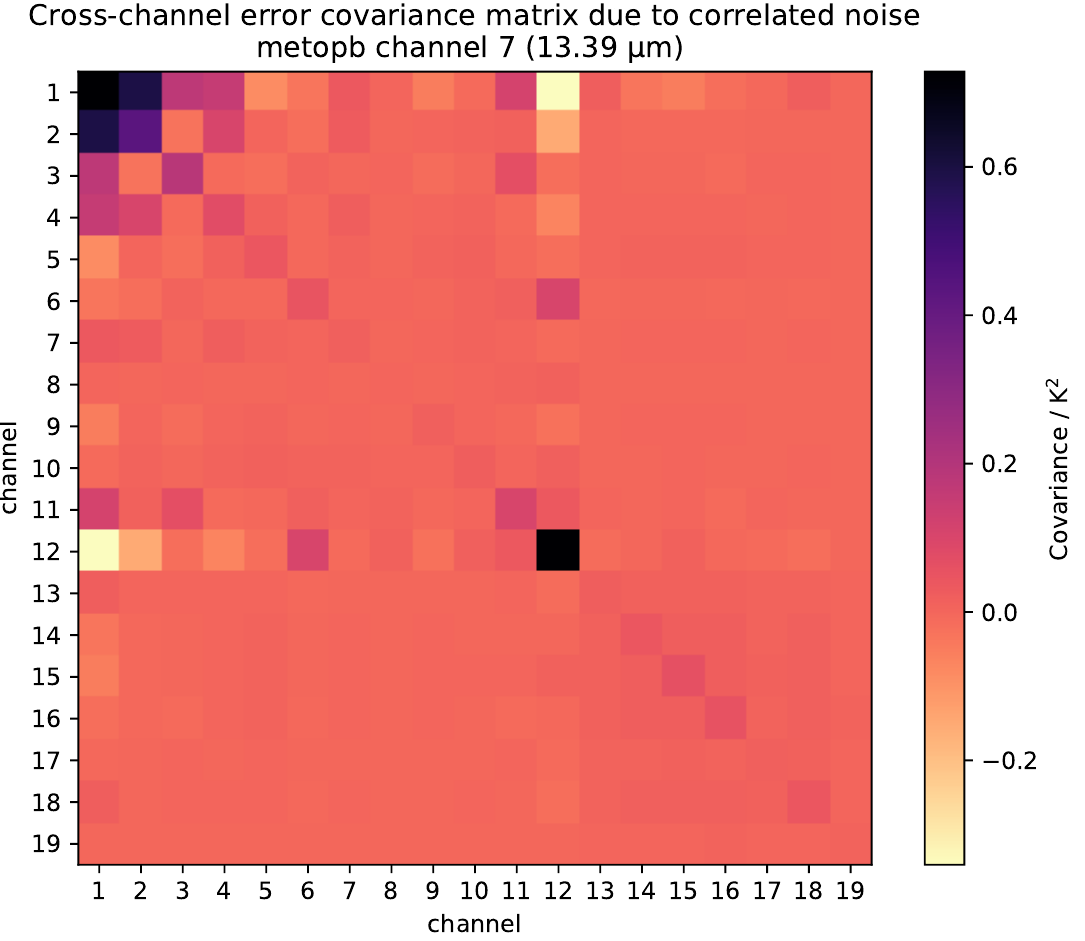
Figure 5. Illustration of covariance matrix for Metop-B channel 7, calculated during 17:39:37–17:49:45 on 27 February